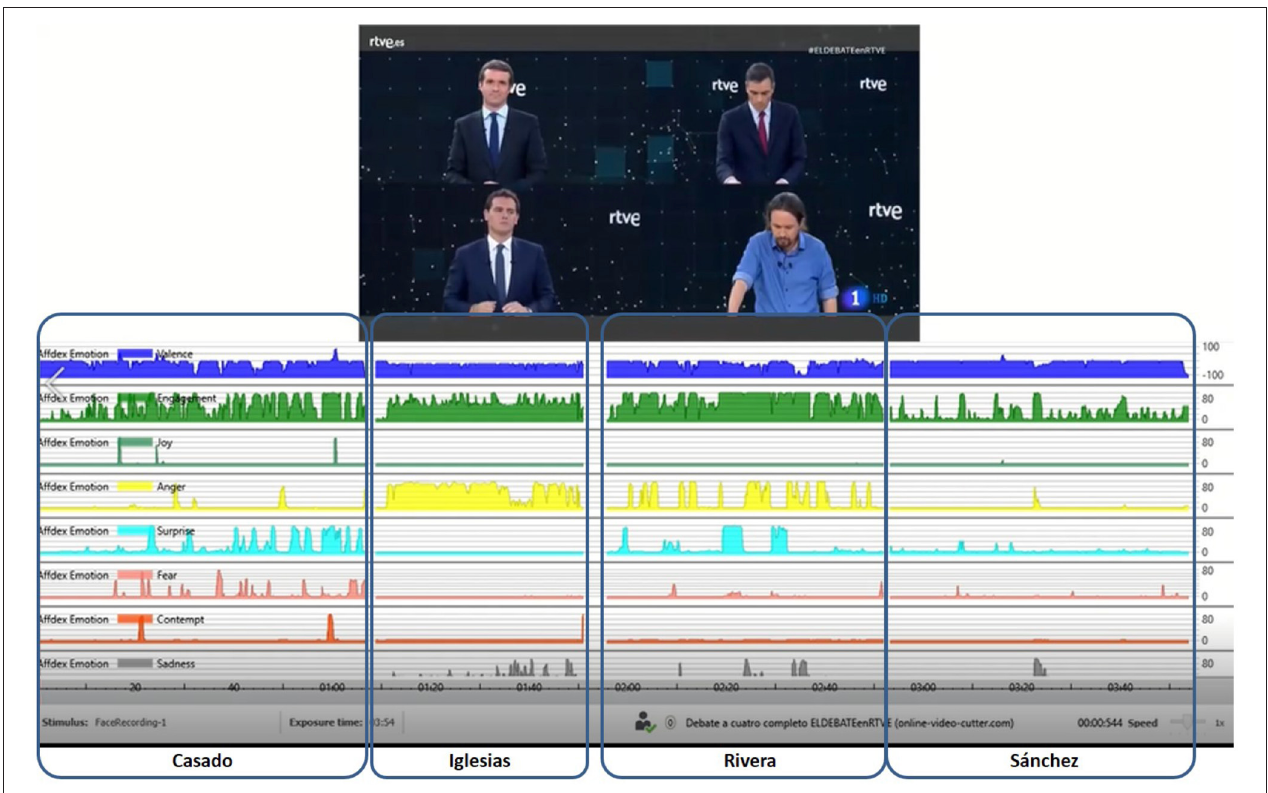
FIGURE 3 | Graphical evolution about the emotions considered along the golden minute by each candidate. The blue shaded column corresponds to the time period analyzed for every candidate. Each row corresponds to the different emotions considered (in order): valence, engagement, joy, anger, surprise, fear, contempt, and